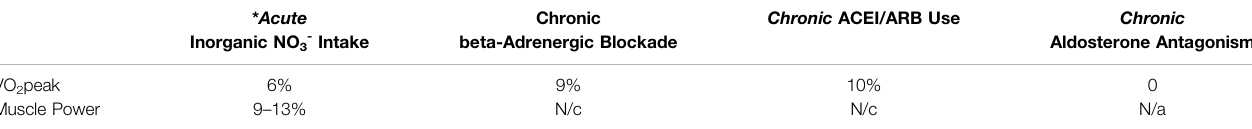
TABLE 2 | Improvements in VO 2 peak and muscle power after dietary NO 3- vs common classes of HF drugs in patients with HF with reduced ejection